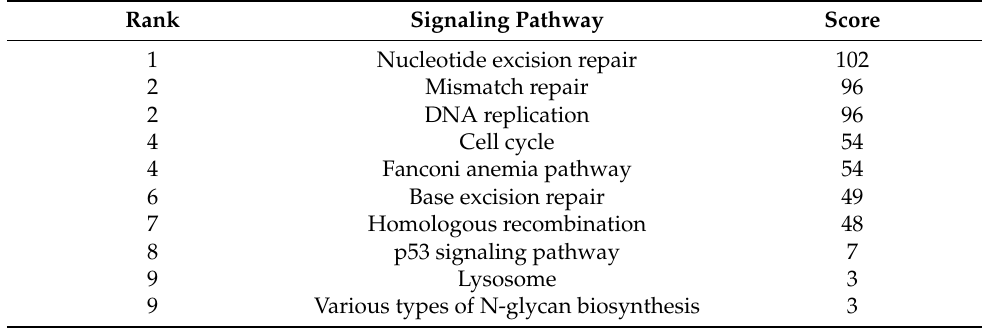
Table 4. Top 10 hub pathways of genes included in c, f, and g ranked by MCC method. Rank Signaling Pathway Score 1 Nucleotide excision repair 102 Mismatch repair DNA replication